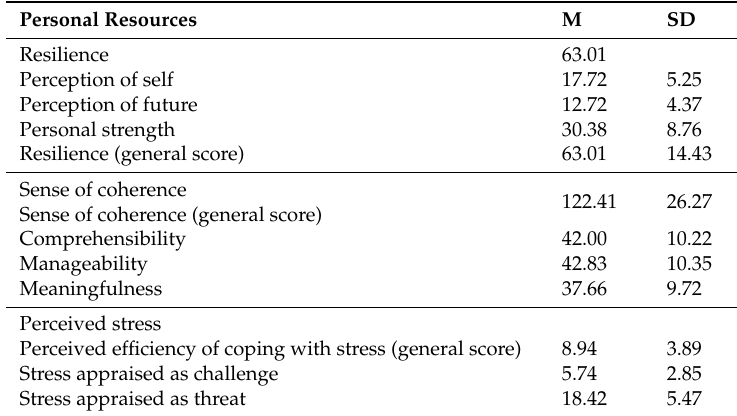
Table 2. Mean scores for components of resilience, sense of coherence, and level of perceived stress in patients with schizophrenia ( N = 201).